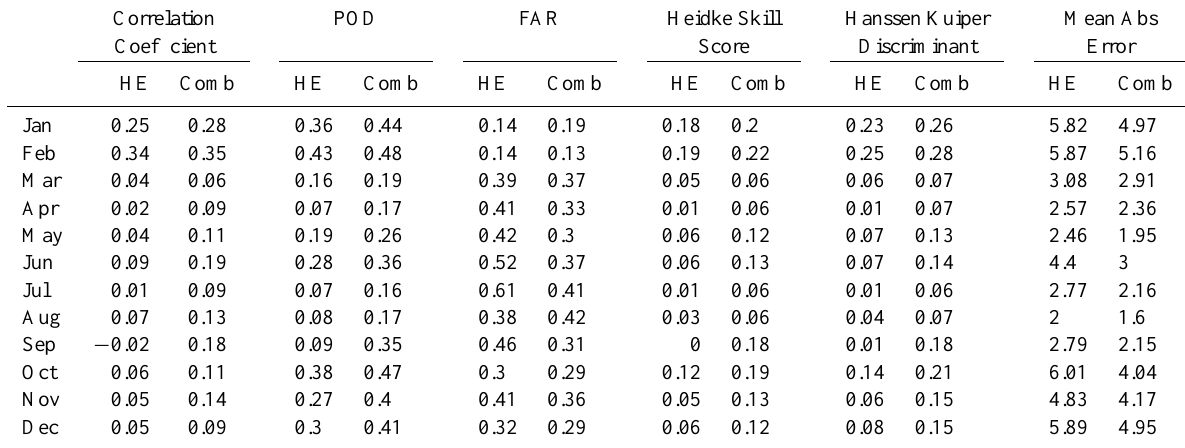
Table 3. Statistical evaluation of HE and COMB in